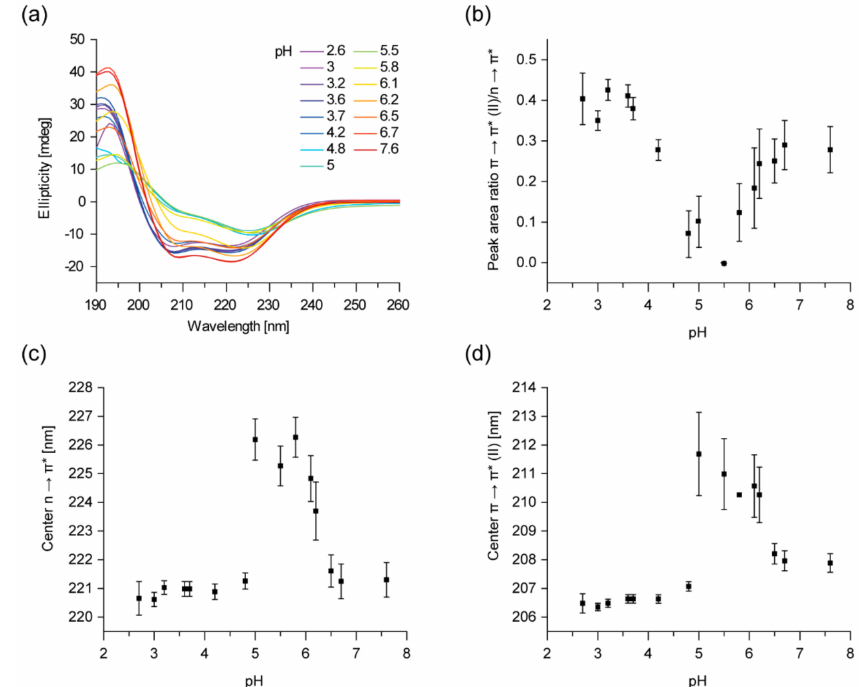
Figure 1. The secondary structure of IM30 (the Inner Membrane-associated protein of 30 kDa) changes in an acidic environment. ( a ) Far UV CD-spectra of IM30 were measured in a pH range from 7.6 to 2.6. The spectrum changes from a typical α -helix spectrum to an atypical CD-spectrum at around pH 5.5 and back to a “typical” α -helix spectrum below pH 4. The spectra were averaged from three samples, no error bars are shown. ( b ) The ratio of the n → π * transition peak area and of the parallel